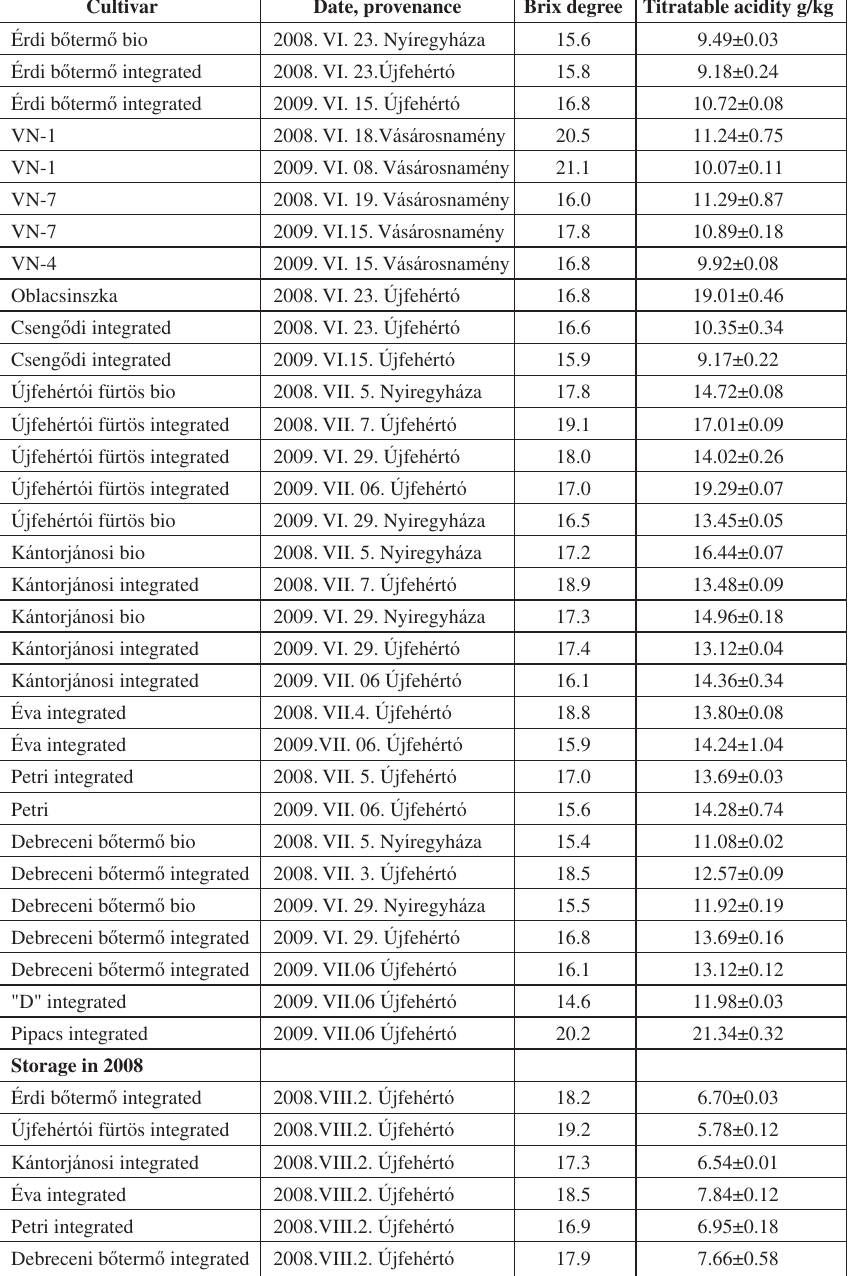
Table 2: Titratable acidity and Brix degree of different varieties of sour cherry cultivated under conventional and organic farming conditions at different provenances.